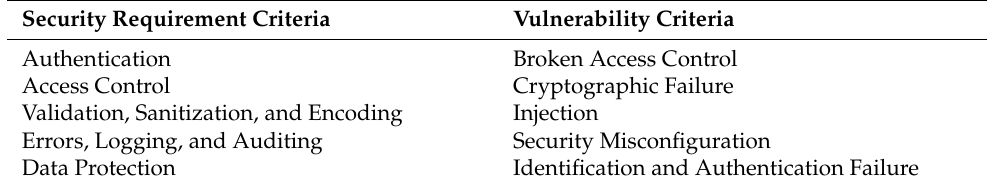
Table 1. Exemplary assurance criteria in web